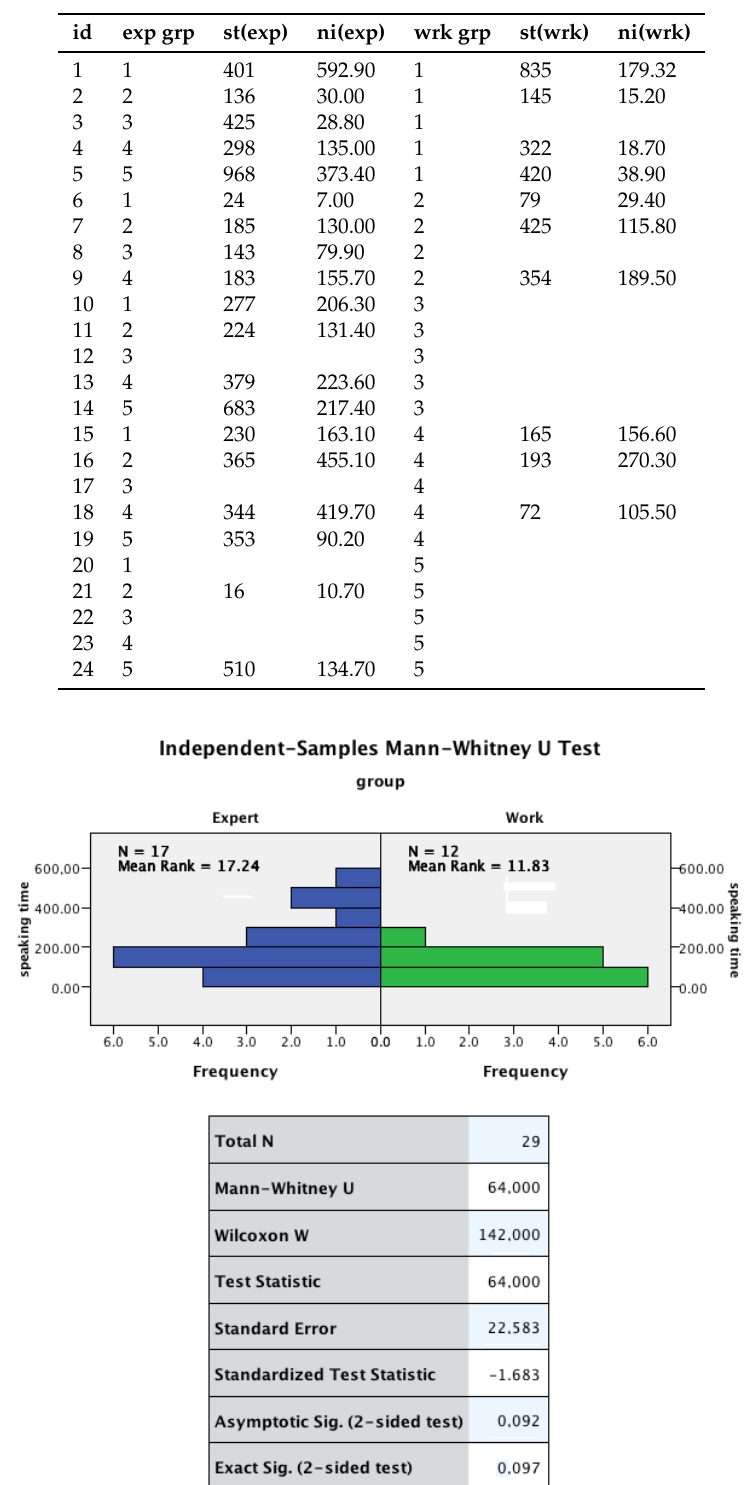
Table 4. Data collected in the case study. id: student id, exp grp: expert group, st(exp): speaking time in the expert group stage, ni(exp): number of interventions in the expert groups stage, wrk grp: work group, st(wrk): speaking time in the work groups stage, ni(wrk): number of interventions in the work groups stage.